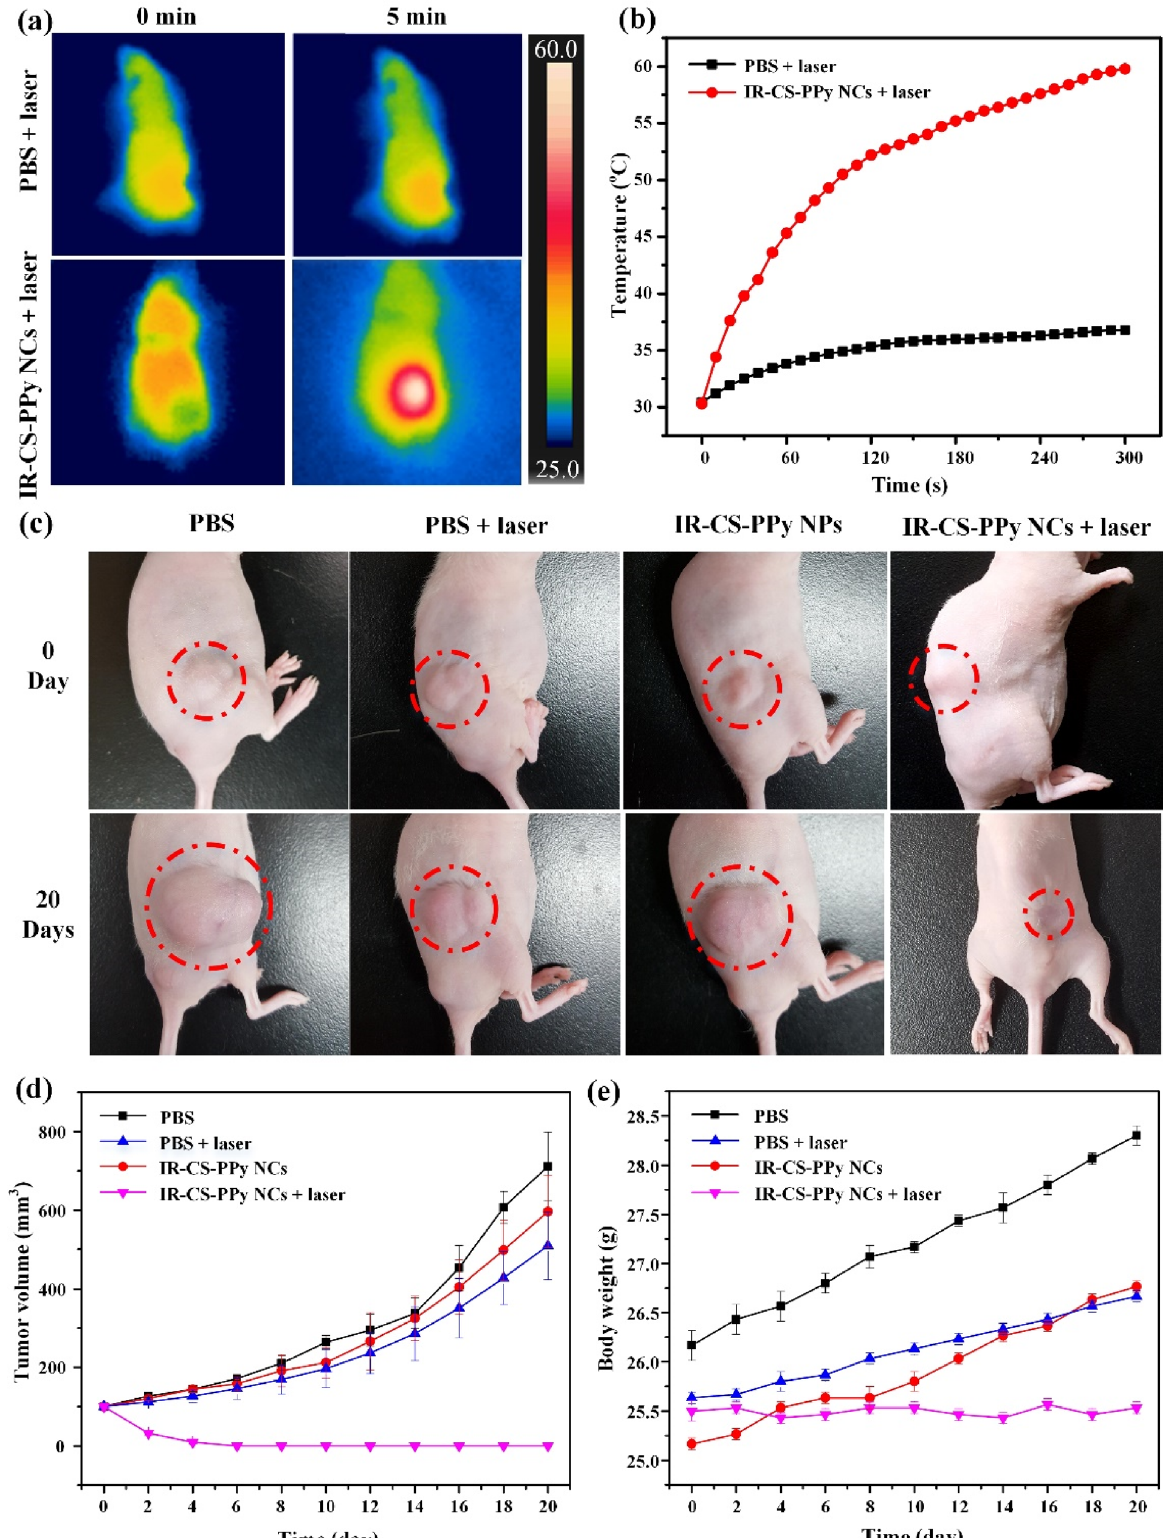
Figure 8. ( a ) NIR thermographic images of tumor-bearing mice with intratumoral injection of PBS and IR-CS–PPy NCs with 808- nm NIR laser irradiation at 2.0 W/cm 2 for 5 min. ( b ) Temperature change of tumor-bearing mice after intratumoral injection of with IR-CS–PPy NCs with 808-nm NIR laser irradiation at 2.0 W/cm 2 for 5 min. ( c ) The digital photographs of tumor-bearing mice taken at day 0 before treatment and 20 days after treatment. ( d ) Tumor volume growth curves of different groups of mice after different treatments. Data presented as mean ± standard deviation. (n = 3). ( e ) The body weight after different treatments indicated in 20 days. Data are shown as the mean ± standard deviation (n =